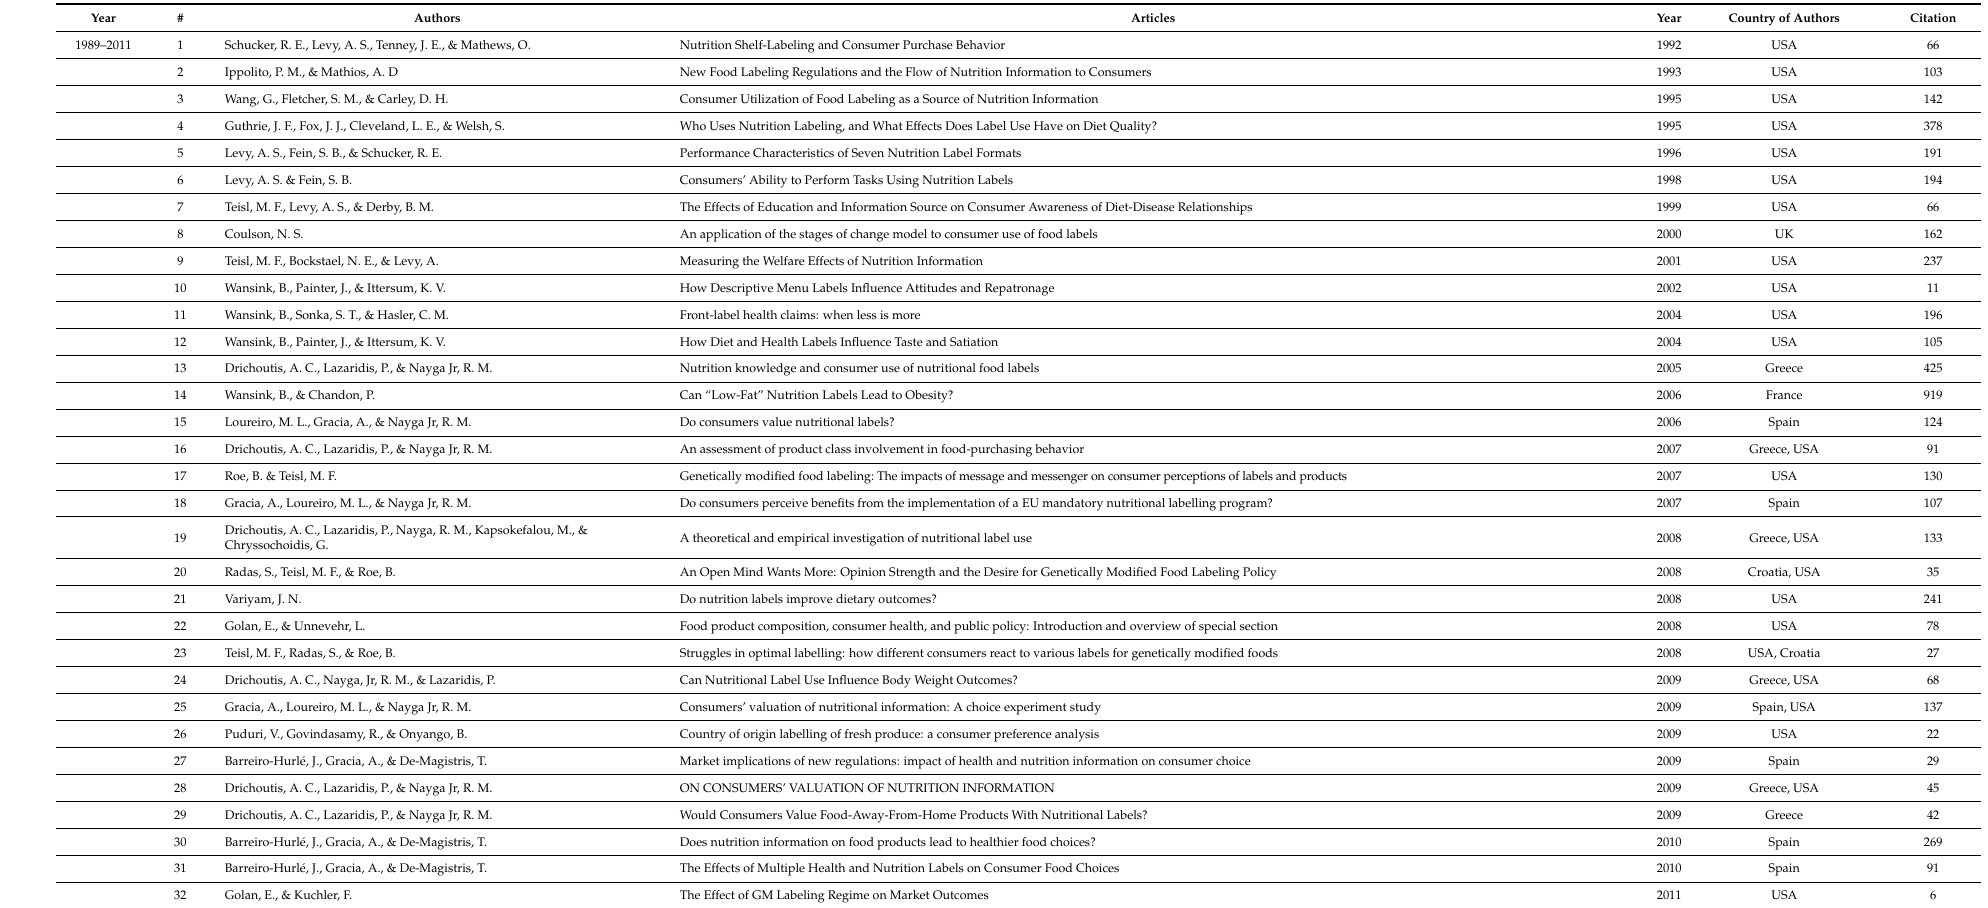
Table 6. Composition of co-citation network 2 in terms of authors, articles, year, country of authors and